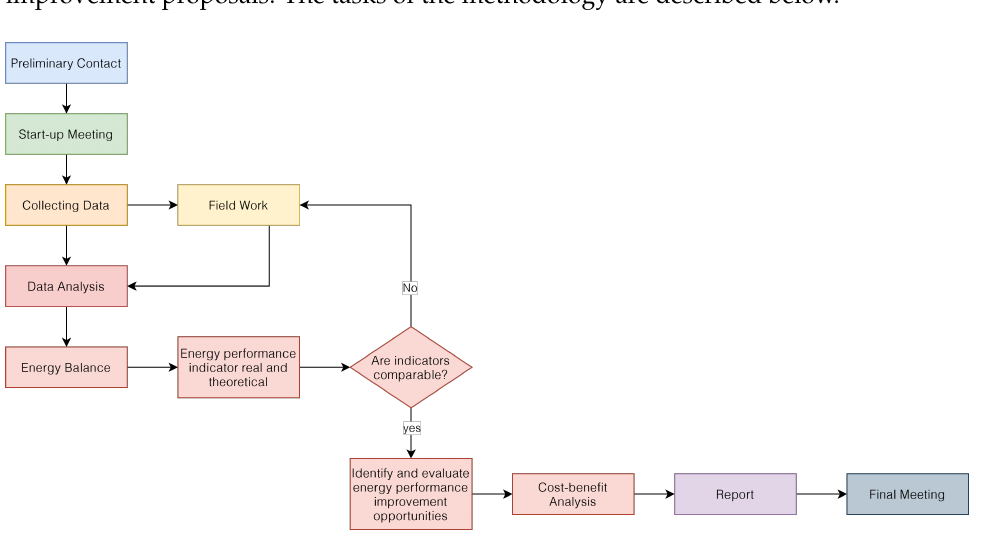
Figure 2. Methodology to analyze energy use and improvement